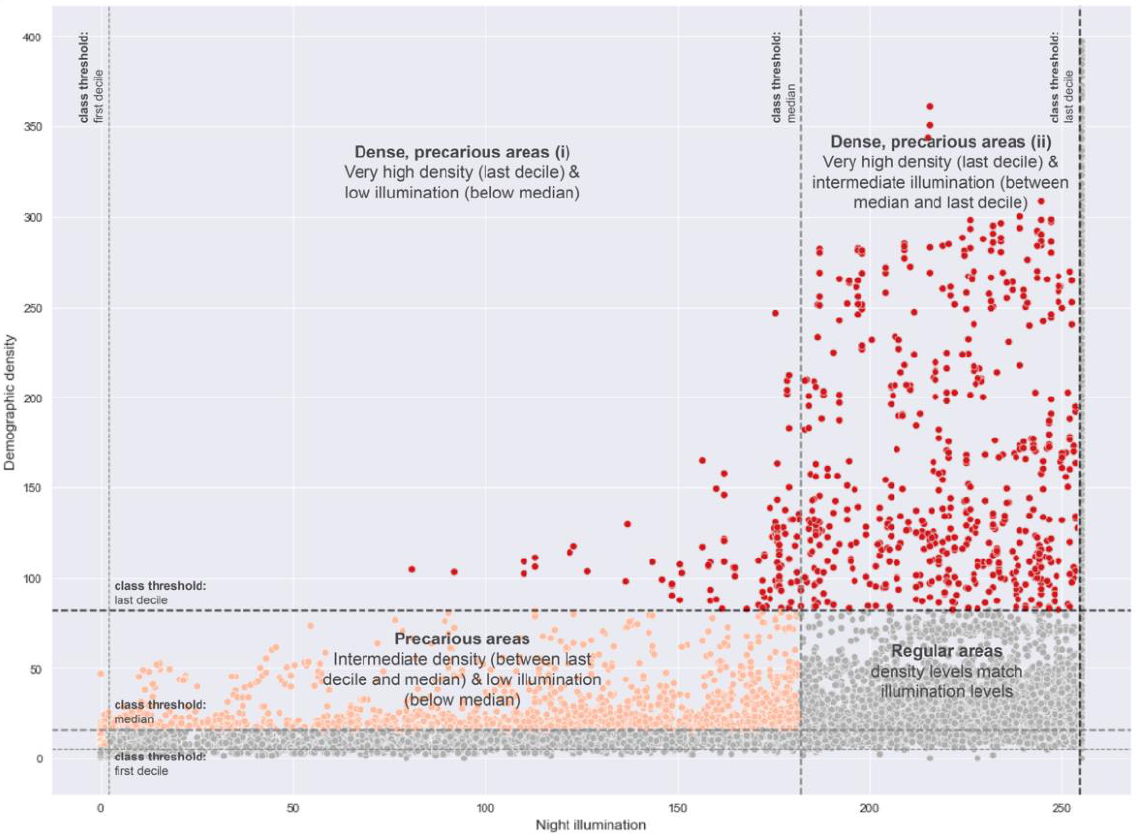
Figure A1. Scatterplot showing the reclassification of urban pixels (300 × 300 m) according to demographic density and night illumination. Elaborated by the authors.